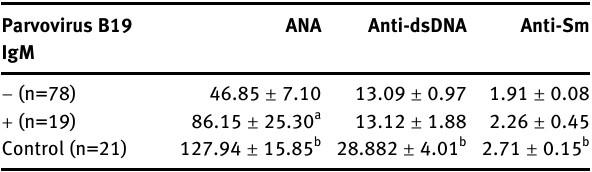
Table  : Upregulation of autoantibodies in Parvovirus B  infected